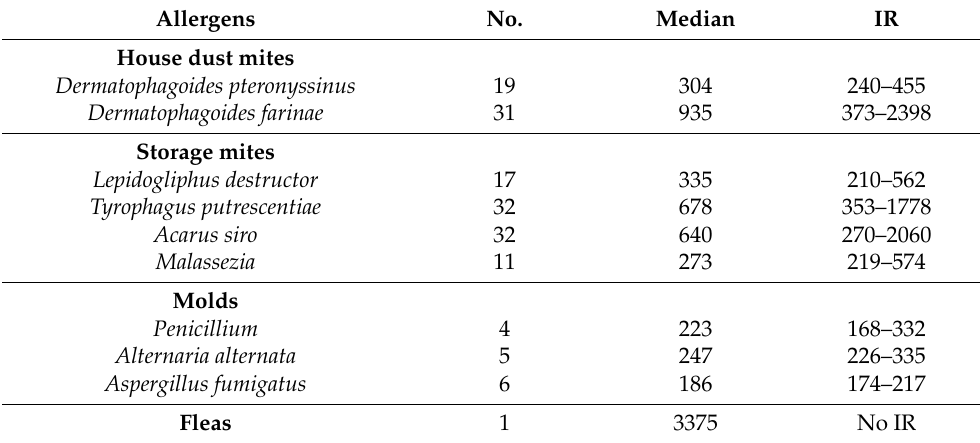
EAU, ELISA Absorbance Units; IN, indoor allergen panel; IR, interquartile range.